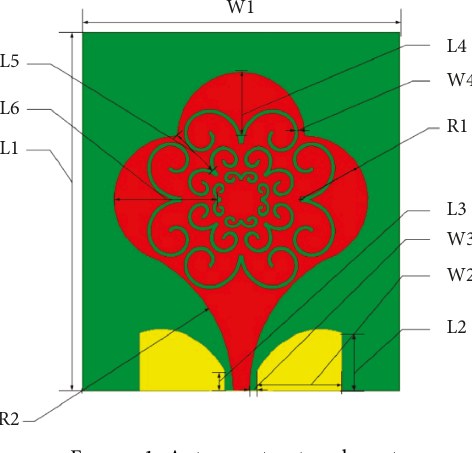
Figure 1: Antenna structure layout. Table 1: The dimensions of the proposed antenna design. Dimensions parameters